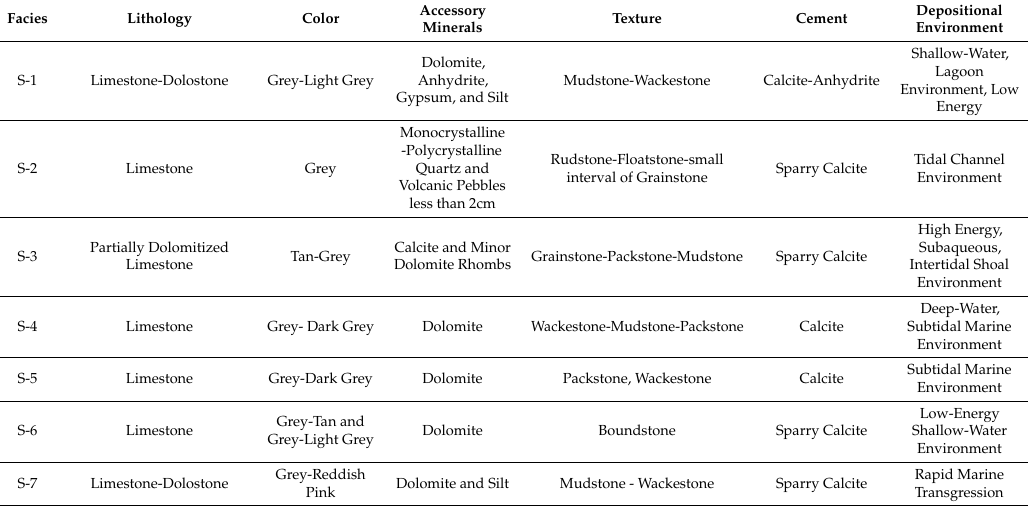
Table 1. The seven lithofacies of the Upper Smackover Formation in southwest Alabama (adapted from